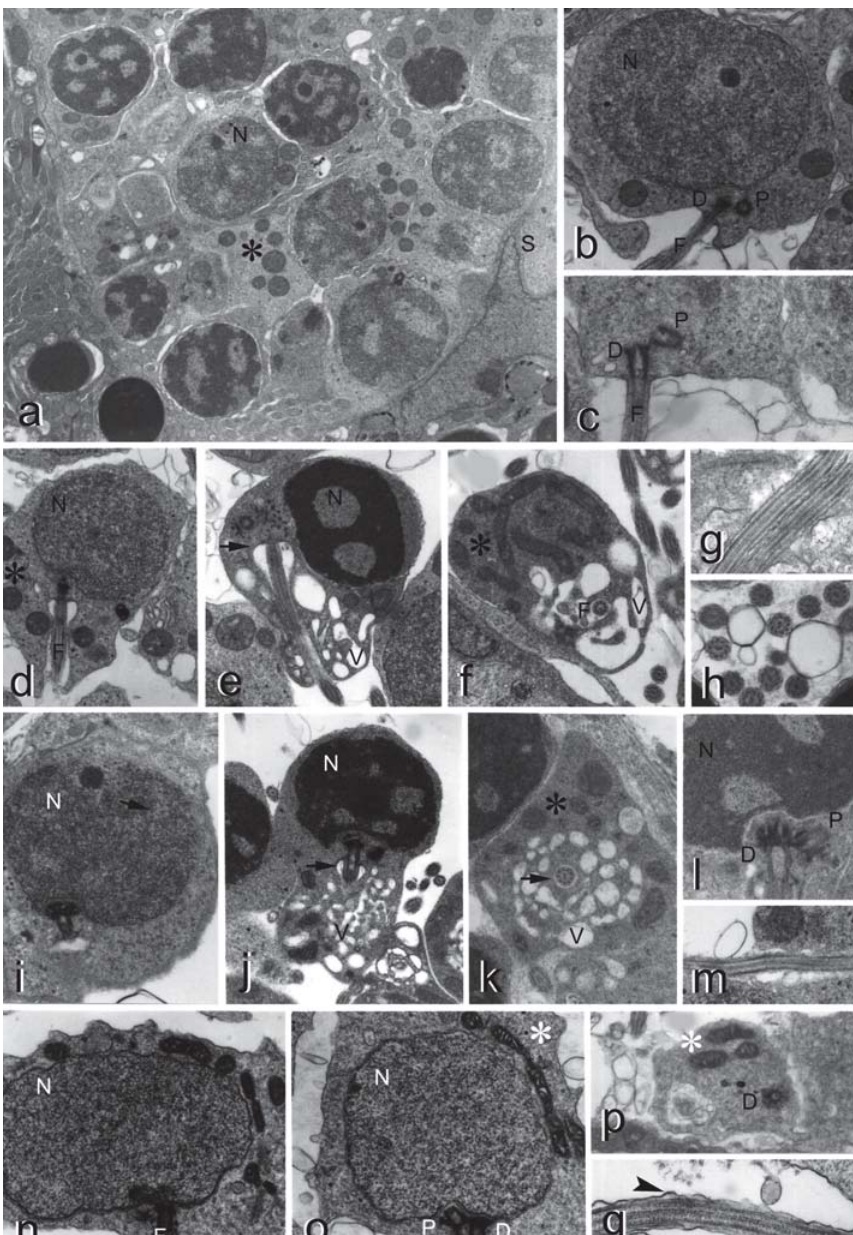
Fig. 7. Spermiogenesis in Callichthyinae. a to h ) Hoplosternum littorale . a ) Spermatid cyst. b and d ) Early spermatids